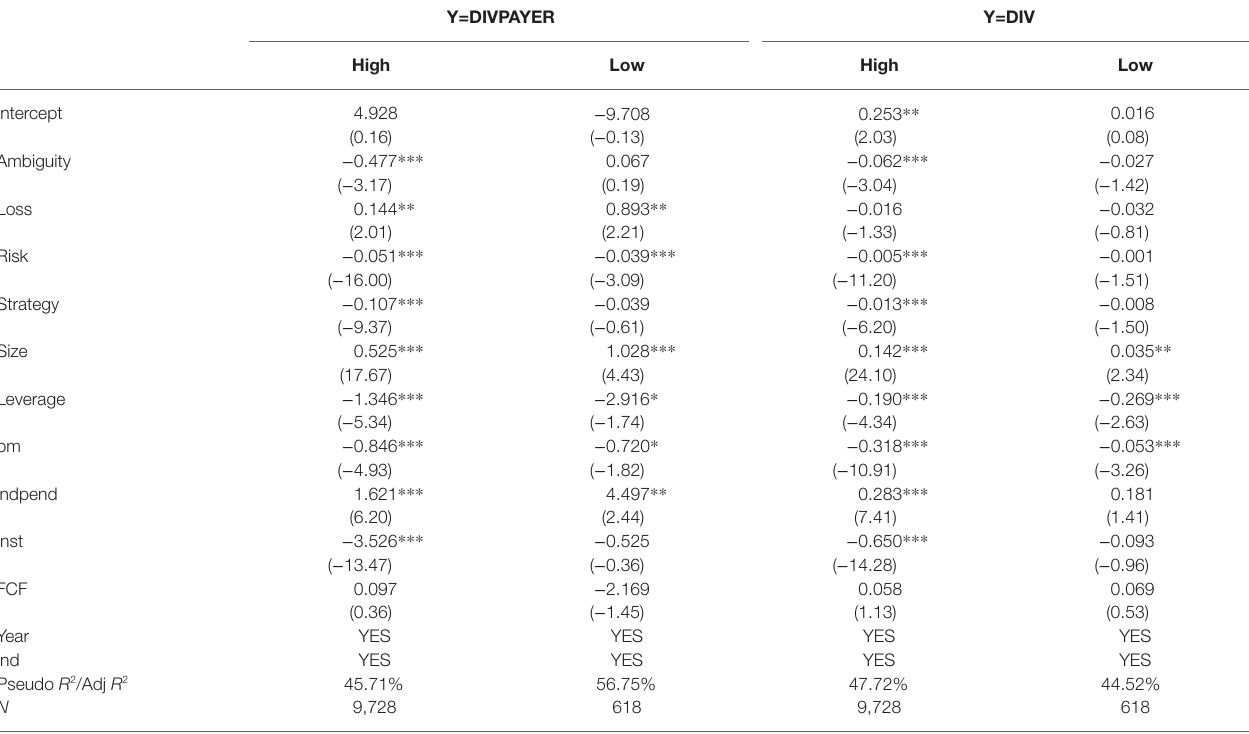
TABLE 8 | The effect of behavior foundations and business strategy on the dividend policy with high/low growth